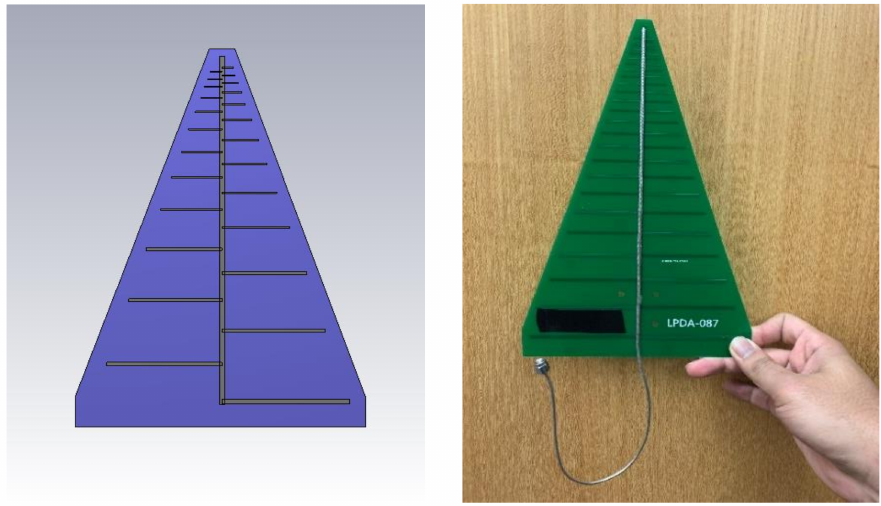
Figure 11. CST model ( left ) and fabricated model ( right ) of the conventional PLPDA antenna. The CST model consisted of 83,184,192 hexahedral mesh cells with the smallest cell size of 0.35 mm. The simulation of this model was performed in the time domain with − 50 dB accuracy and hardware acceleration using an Nvidia GP100 GPU. The dimensions of this antenna are listed in Table 2.